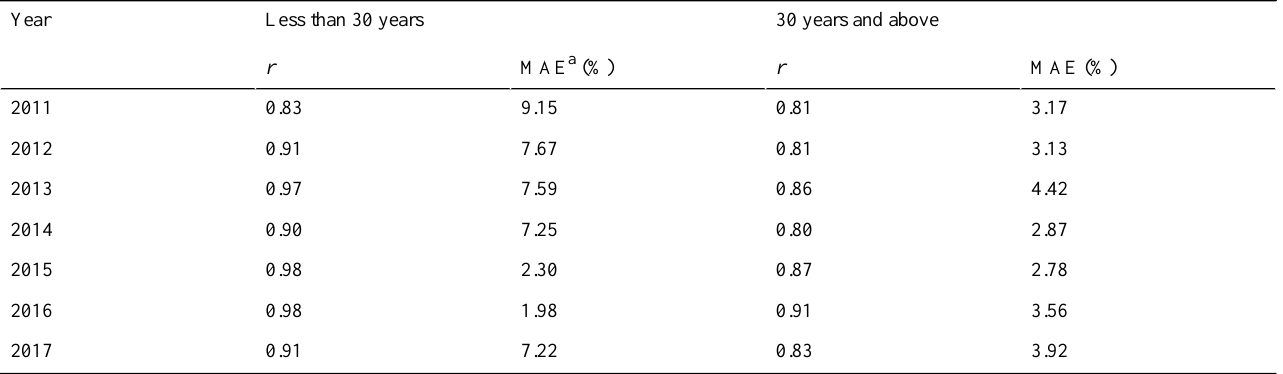
Table 5. Subgroup (age) prediction performance for gonorrhea. P <.001 for all r